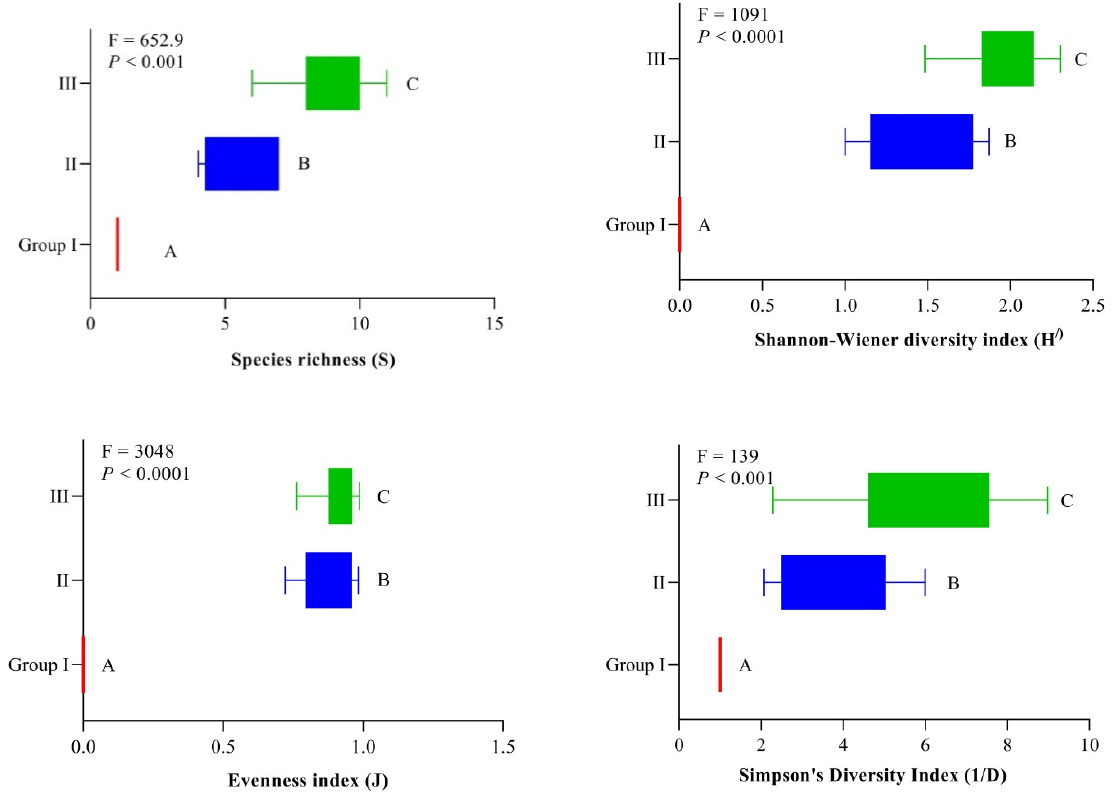
Figure 4. Diversity indices of the communities dominated by Silybum marianum with progressive decrease of importance value index. Note: Different letters indicate significant variation at p < 0.05. Table 3. Environmental and soil variables associated with Silybum marianum